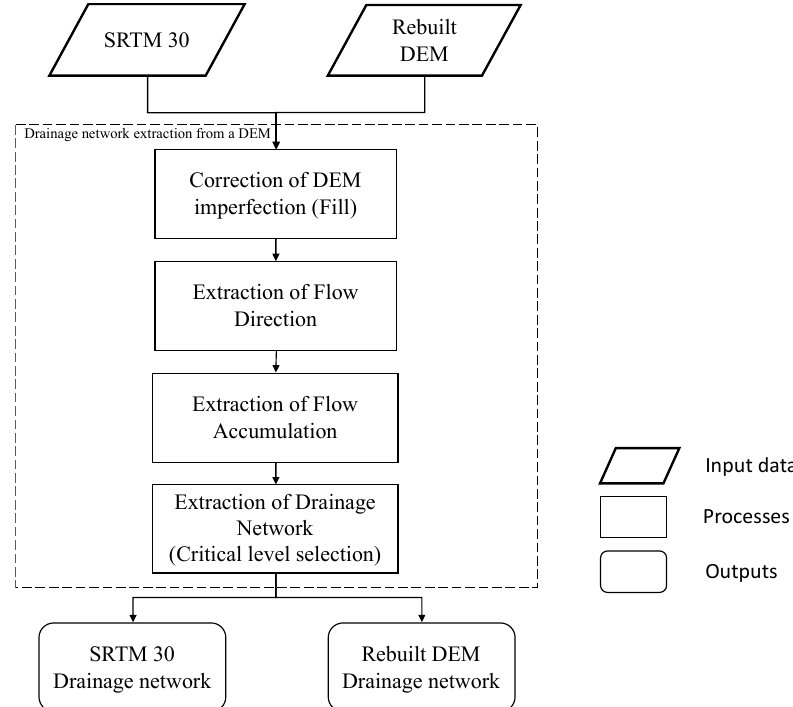
Figure 12. Flowchart of the drainage networks extraction process from SRTM 30 and the rebuilt DEM.